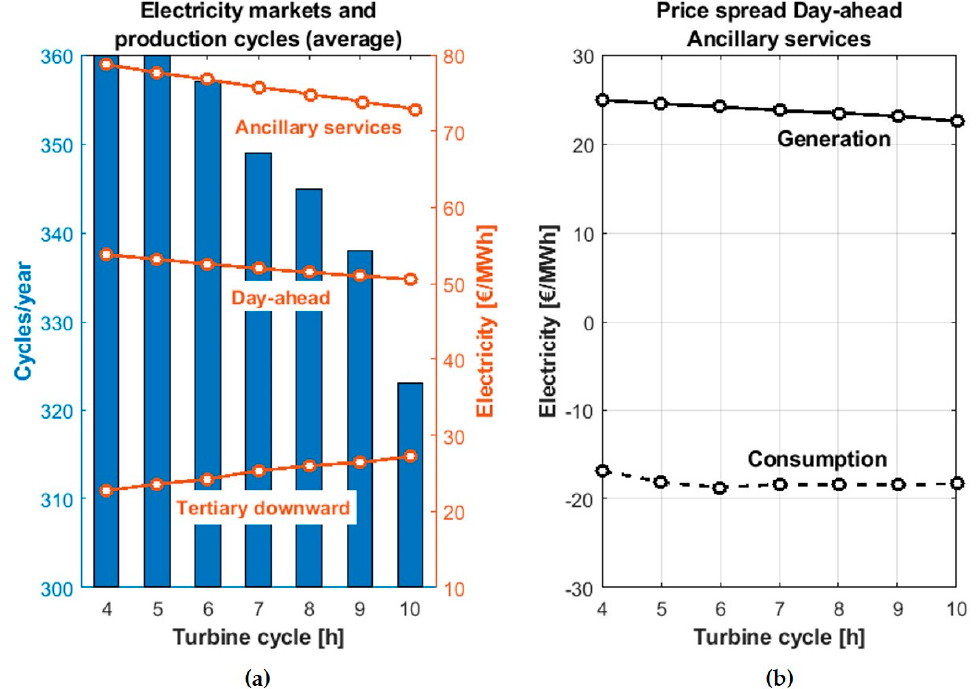
Figure 4. Analysis of electricity markets. ( a ) Maximum electricity prices in the day-ahead and ancillary services markets; minimum costs in the downward tertiary regulation service and annual generation cycles. ( b ) Price spread between the day-ahead and the ancillary services markets.